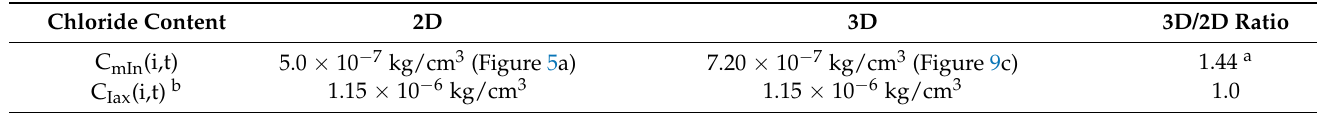
Table 5. Comparison of both